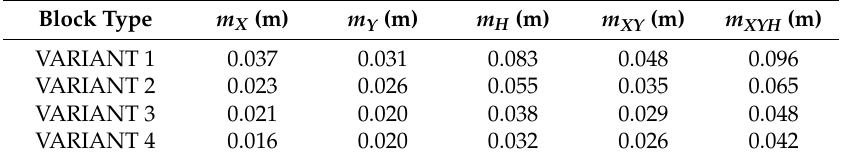
Table 6. Comparison of control point mean-squared errors for all of the data processing variants.